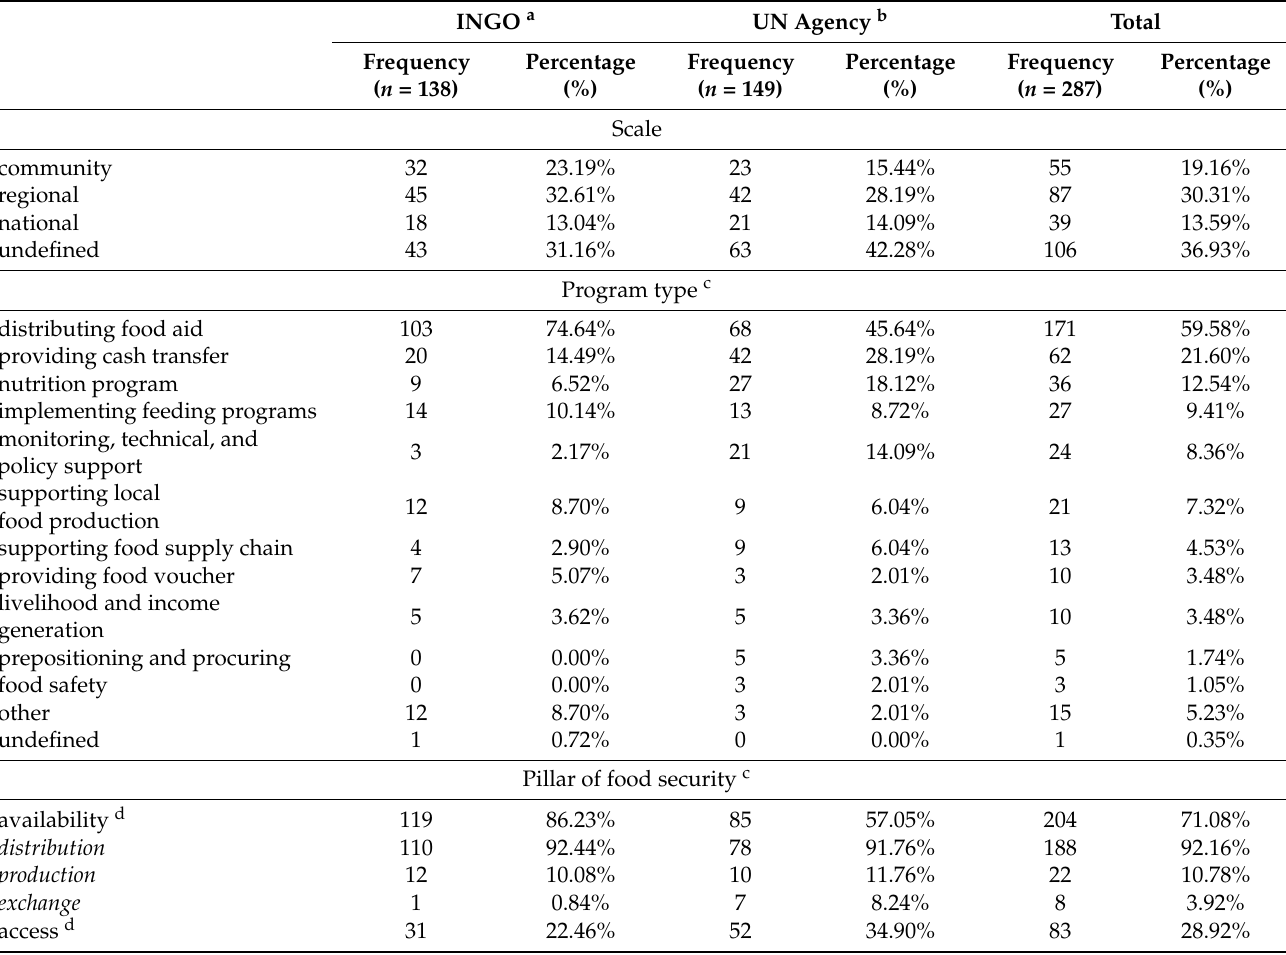
Table 4. Characteristics of food security interventions delivered by INGOs and UN agencies in response to the